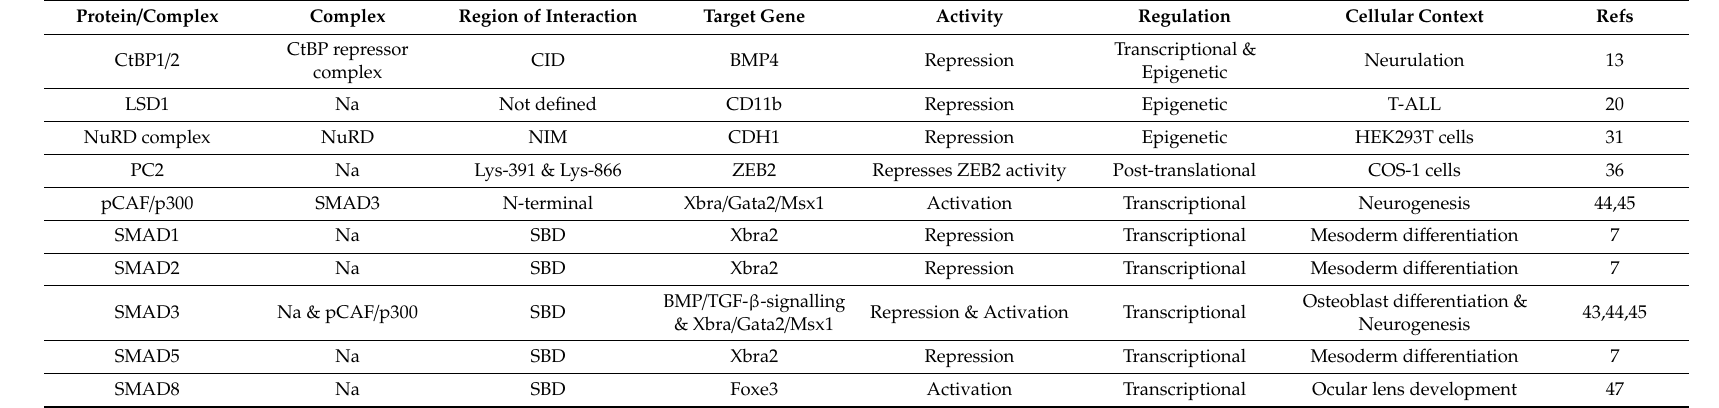
Table 2. Summary of known interaction partners of